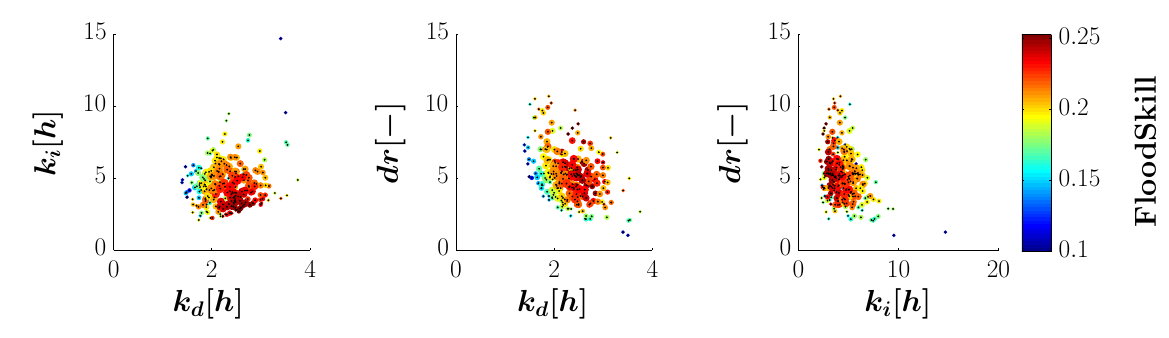
Fig. 10: Scatter plot of the good parameter vectors shaded according to their validation performance. Red points have a good validation performance, blue points are worse (cf. colorbar). The size of the shades is proportional to the data depth of each point with respect to the whole cloud.